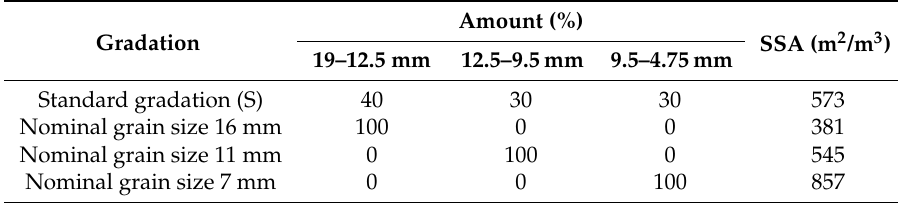
Table 2. Gradation and specific surface area (SSA) of coarse